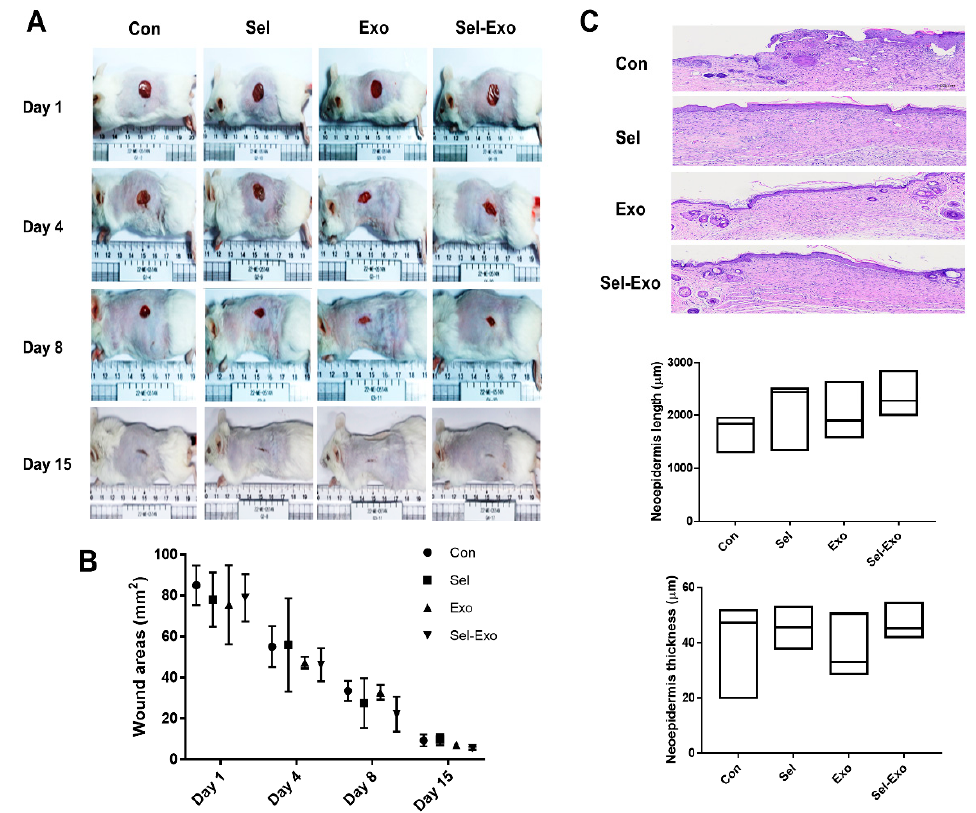
Figure 8. In vivo wound healing effect. ( A ) Optical images were obtained from the control group, selenium group, exosome group, and selenium-treated exosome group at days 1, 4, 8, and 15 (scale = cm). ( B ) Quantitative analysis, based on optical images, was performed on the wound area. ( C ) H&E-stained images of tissues and related quantification of neoepidermis length and neoepidermis thickness were conducted in the control group, selenium group, exosome group, and selenium-treated exosome group at day 15 (5 male donors from each group) (scale bar = 300 μ m).